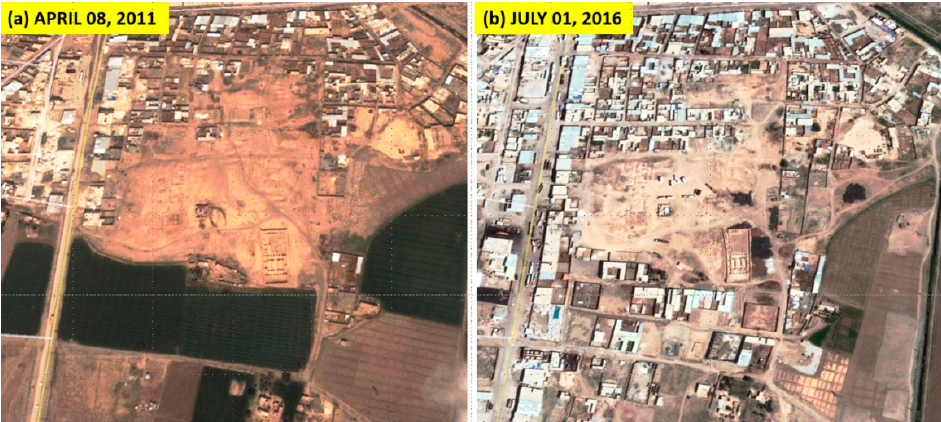
Figure 9. Satellite images of conflict zones in Syria: ( a ) and ( b ) the Abbasid Palace area encroachment as observed from images taken in April 2011 and July 2016, respectively [Images are reproduced from Casana and Laugier et al. studies [62] Image sources: GoogleEarth images date of access: 28 November, 2020].